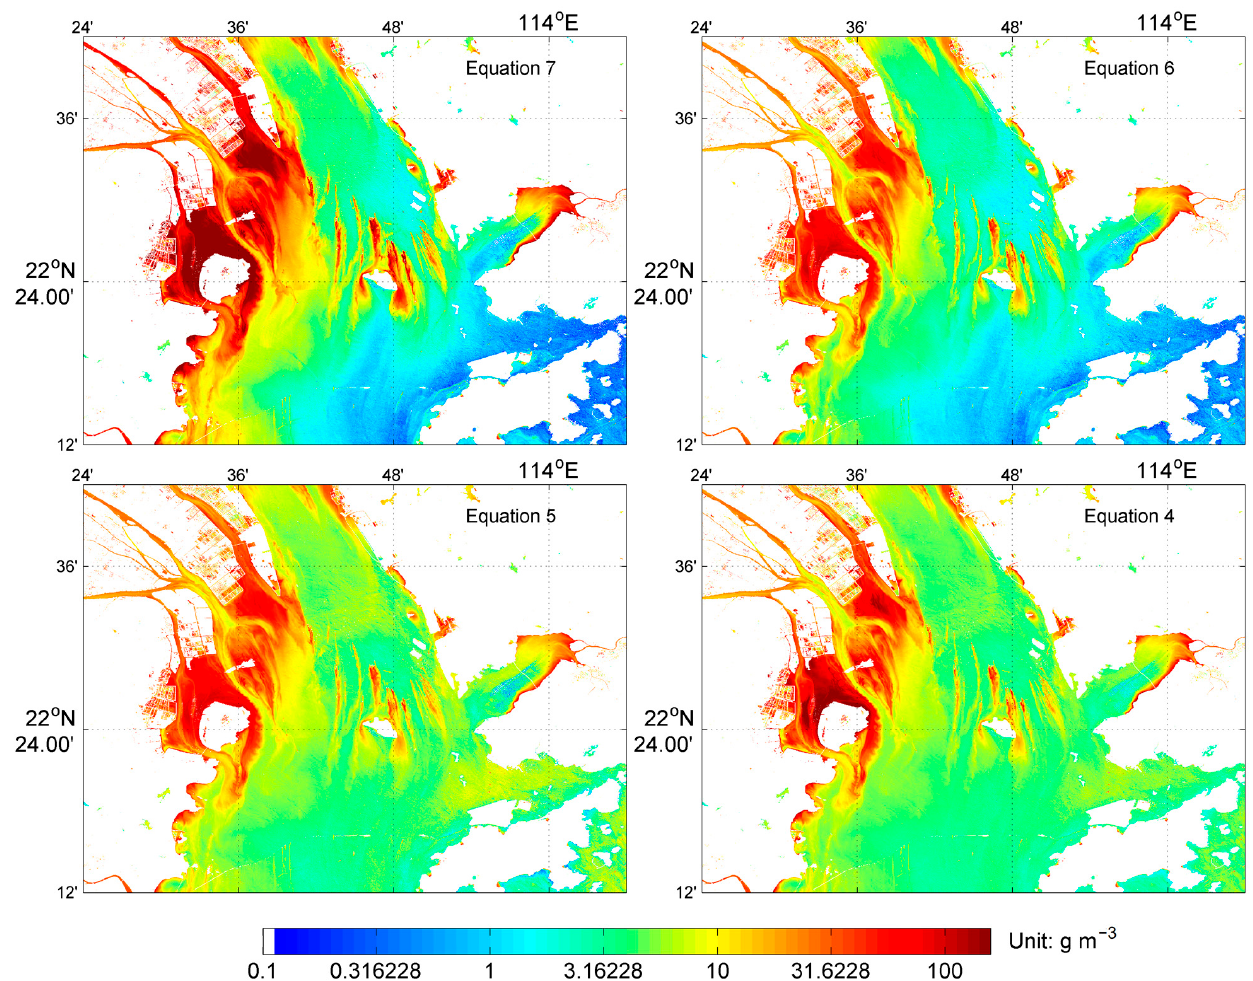
Figure 3. The suspended sediment distribution derived using different algorithms (Equations (7) to Equation (4)). The scene was captured on 16 November 2014.